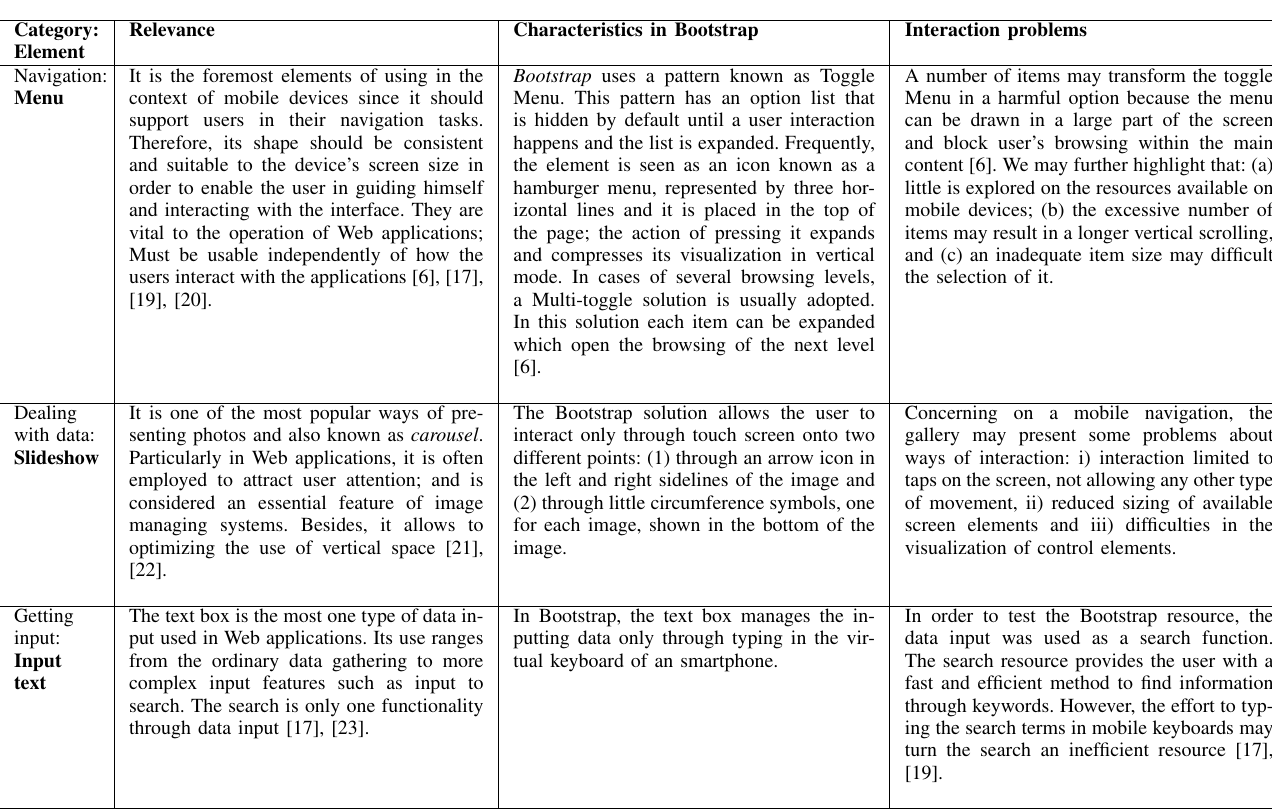
TABLE I F E F INTERACTION ELEMENTS - UTILIZATION CHARACTERISTICS AND INTERACTION PROBLEMS